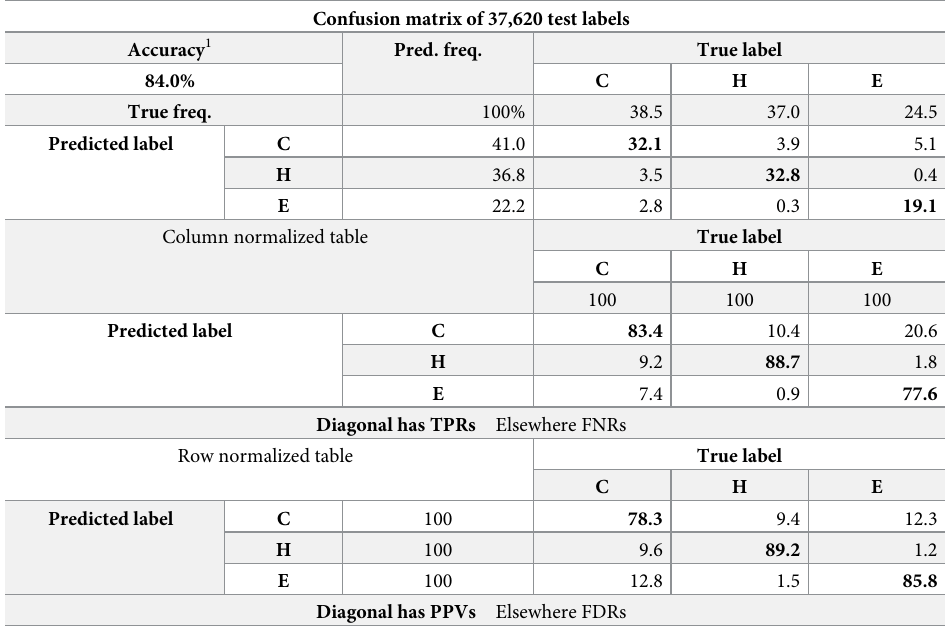
Table 3. Rule #1 of the popular 3-label ( H , C , and E ) alphabet: (1) confusion matrix, (2) true positive rates (recalls) and false negative rates and (3) positive predictive values (precisions) and false discovery rates of SecNet